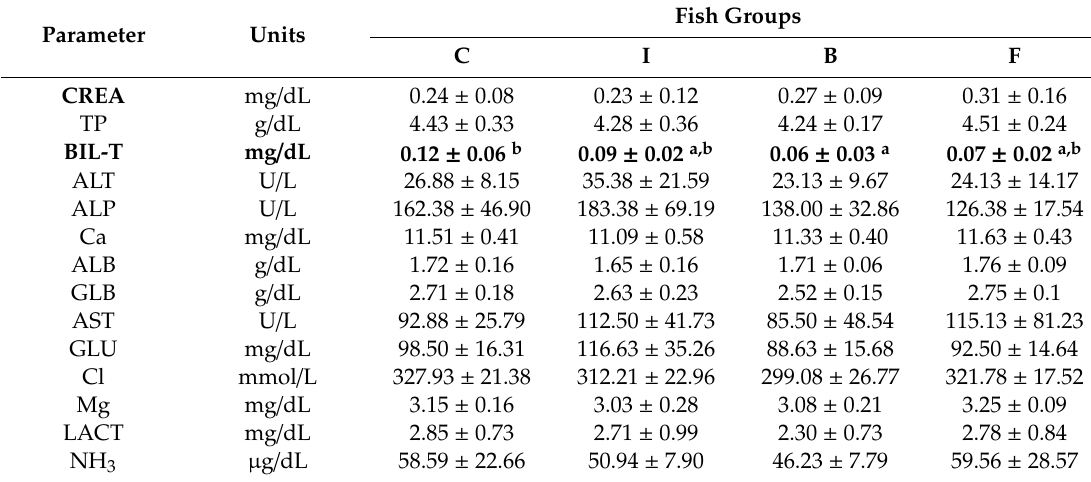
Di ff erent letters in the table point statistical significance.